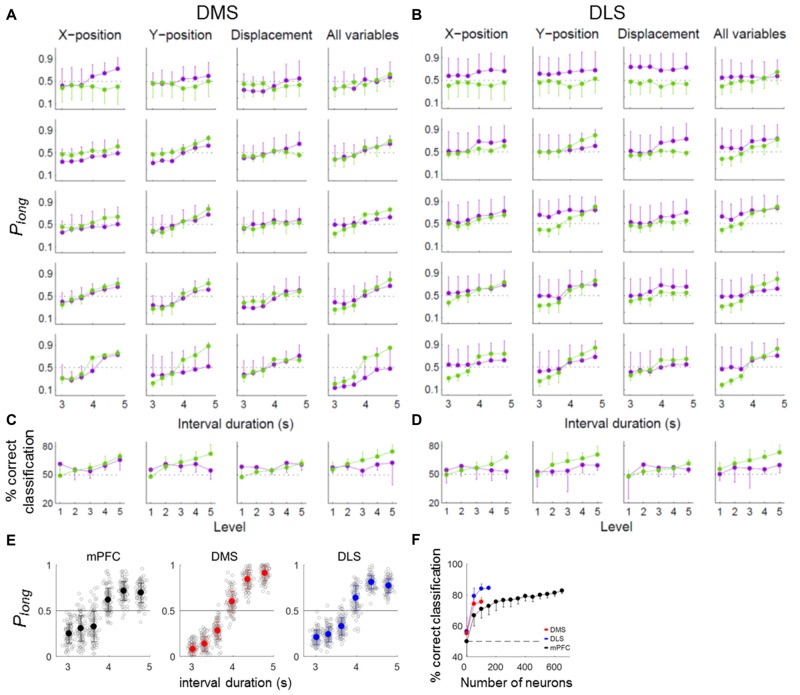
Effect of behavior on timing-related neural activity. (A–D) Neural coding of temporal information for different levels of behavioral variation. To determine whether the temporal information conveyed by DMS and DLS neural activity could be attributed to variations in the animal’s ongoing behavior during each sample interval, we compared neural decoding performance across behavioral sessions by dividing them into quintiles according to the amount of temporal information conveyed by each of the three behavioral variables (X-position, Y-position and displacement) or by all three together. Purple, neural decoding results. Green, behavioral decoding results. (A,B) Probability of long classification (Plong) as a function of sample interval duration. (C,D) Mean % correct classification as a function of behavioral variation. (E,F) Classification of sample-interval length using partial residuals. (E) Length classification was done as in Figure 5B except thatthe partial residuals of a linear regression model containing the behavioral variables (X-position, Y-position and displacement) were used for the linear discriminant analysis instead of raw firing rates. Only correct trials were analyzed. (F) Results of a neuron dropping analysis. The same format as in Figure 5C. Error bars, SD.